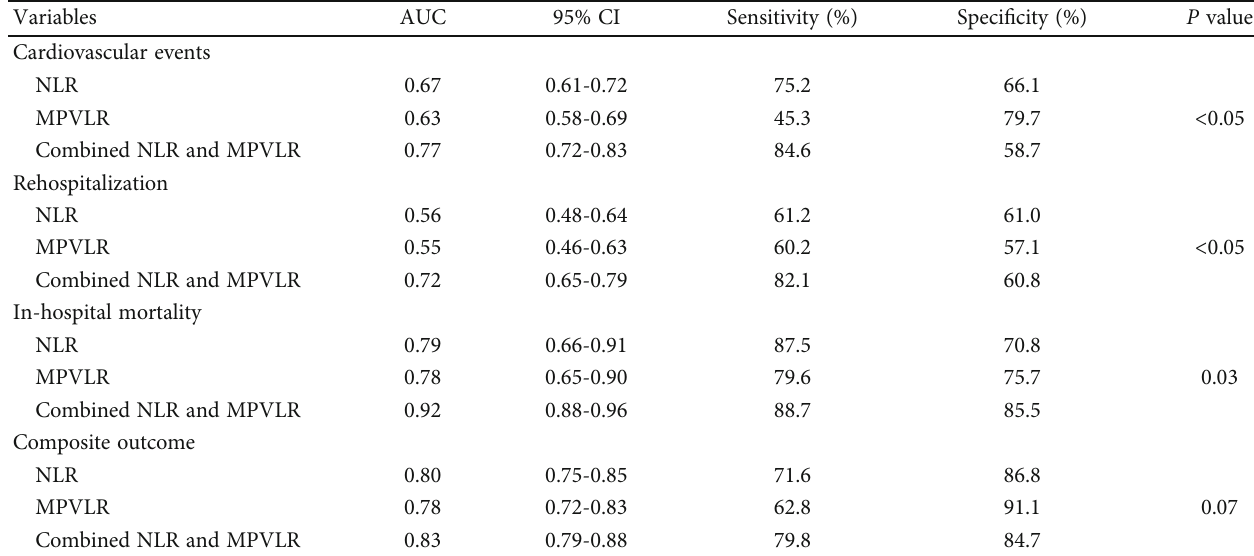
Figure 2: Receiver operating characteristics curves and AUC of NLR, MPVLR, and combined NLR and MPVLR for each outcome. Table 4: Area under the receiver operating characteristics curve (AUC) strati fi ed according to each